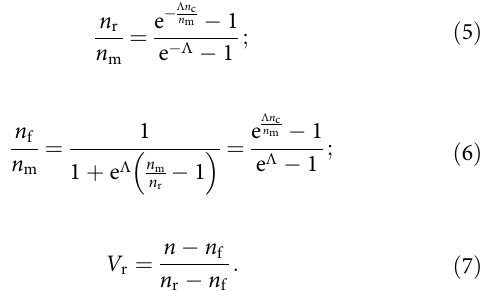
Fig. 3 Features of network structures optimizing the total entropy. a Spatial correlation of connectivity C n ð r Þ = n ð r Þ n ð 0 Þh i (cid:2) n 2 entropy favored networks, N = 576. b Probability distribution of rigid cluster sizes ρ ( S ), collapse for a wide range in n < n c . c Probability in the percolating cluster P ∞ , and d Bulk modulus K and shear modulus G vs. constraint number n for various system sizes N , α = 0.0003. The black solid line is theoretical prediction for the thermodynamic limit N → ∞ . λ ≈ 3.3, so n f ≈ 0.94, n r ≈ 2.76, and n * ≈ 1.85, fi tted by Eqs. (5), (6) and